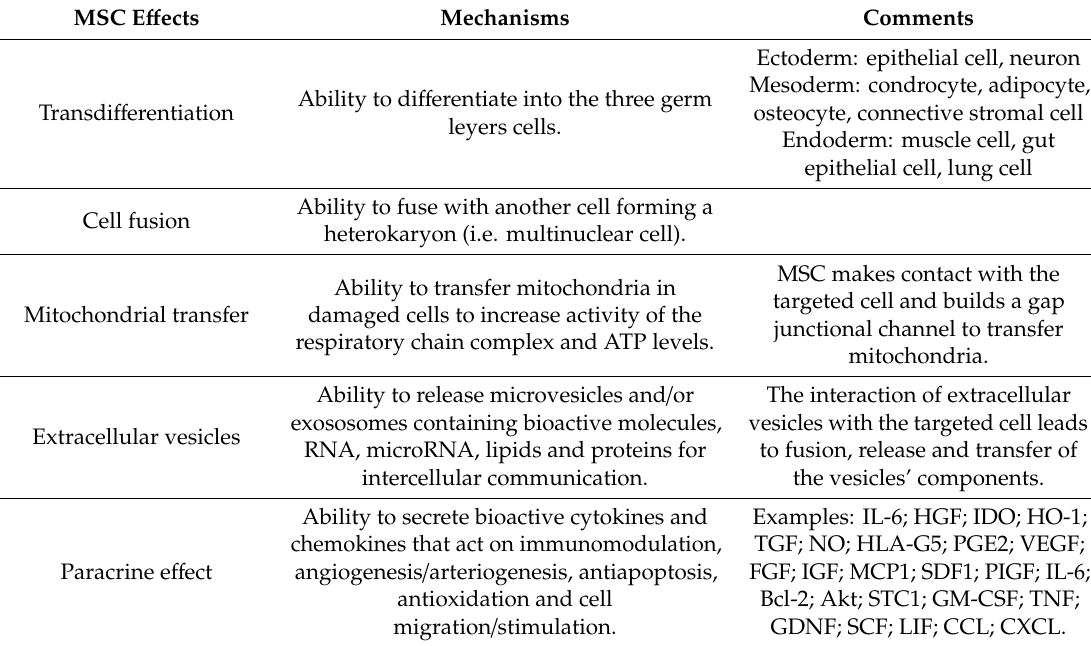
Table 2. Biological actions of MSC-based therapeutic applications